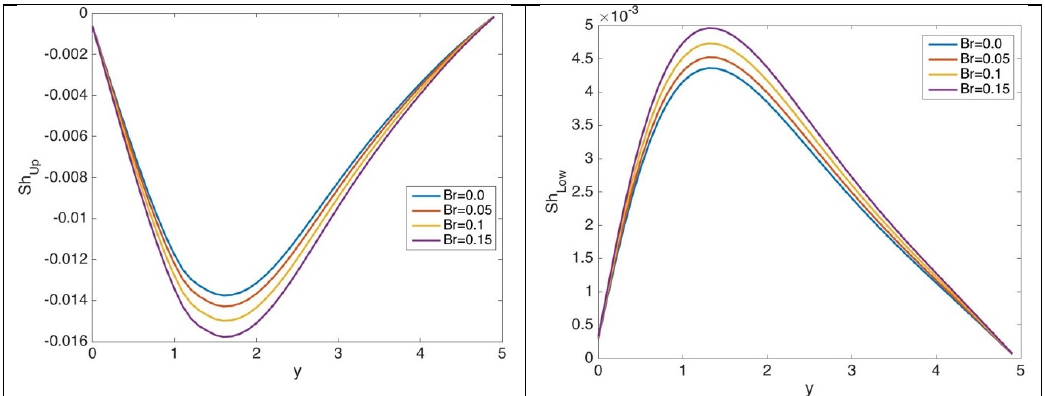
Figure. 9. Local Sherwood number profiles along the left -, right -, upper -, and lower -walls for various values of the parameter Br; Case 1.